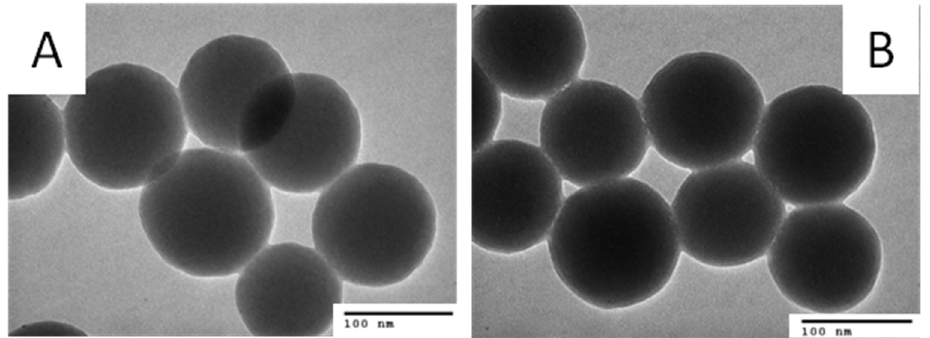
Figure 4. TEM images of SiO 2 ·NPs at scale bare of 100 nm before ( A ) and after ( B ) absorbed DOX·HCl molecules.